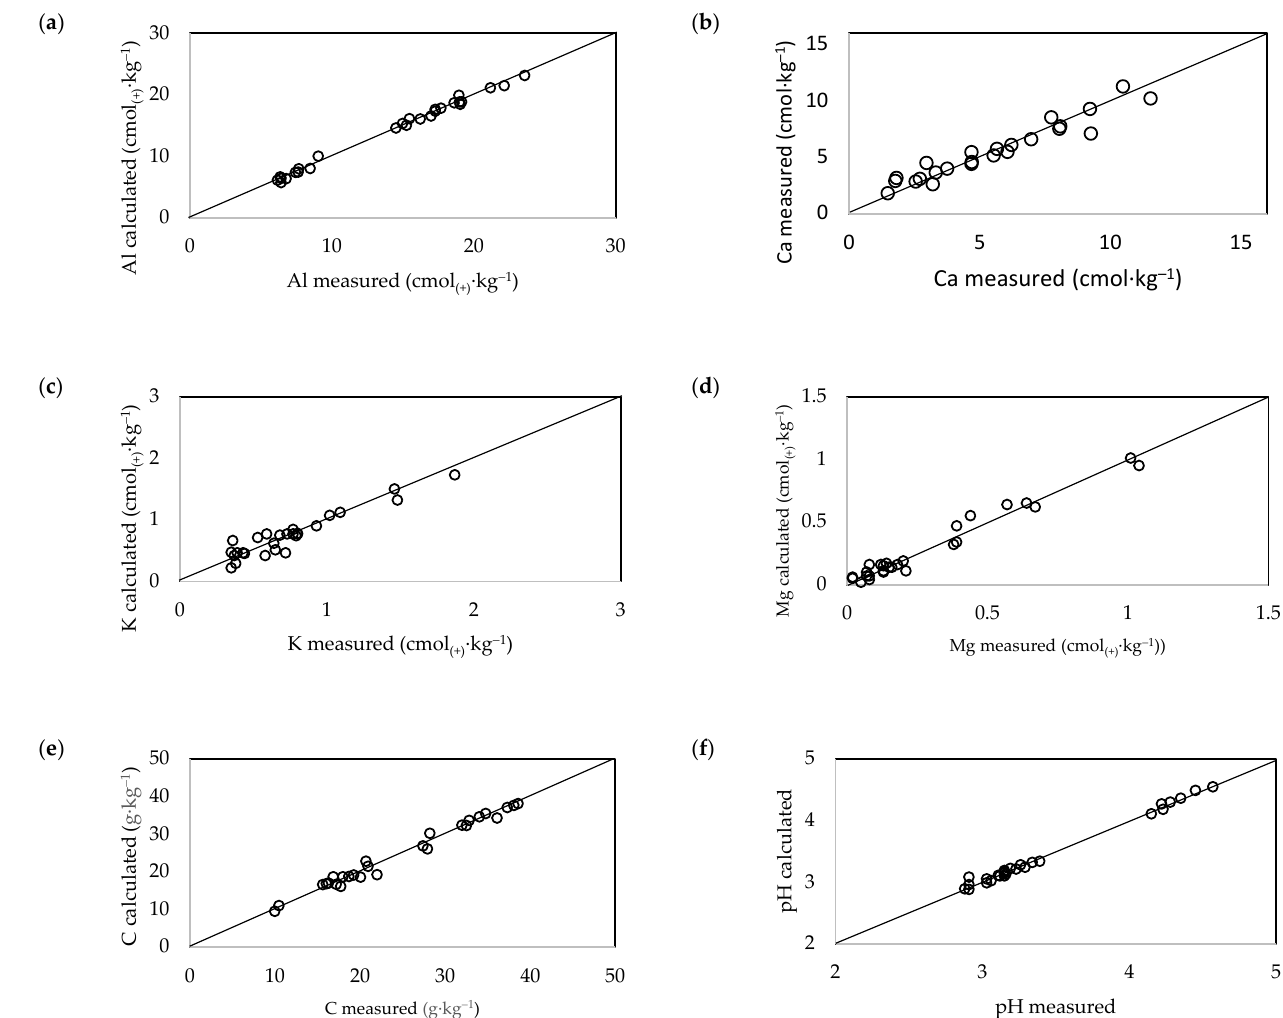
Figure 4. Calibration scatter plots of measured versus predicted values for ( a ) Al 3+ , ( b ) Ca 2+ , ( c ) K + , ( d ) Mg 2+ , and ( e ) C contents, and ( f ) pH of soil under beech stands.